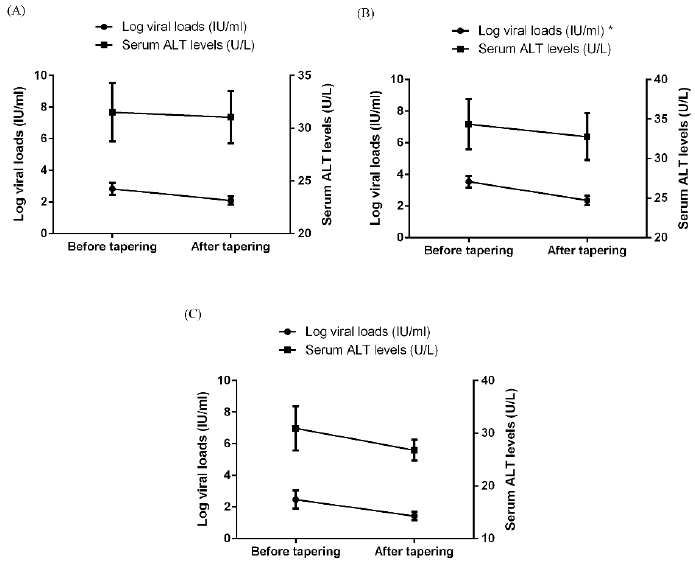
Figure 2. The change in serum levels of viral loads and ALT in RA patients with chronic hepatitis B before and after tapering of b/tsDMARDs, with respect to ( A ) all 40 patients, ( B ) 32 patients with detectable HBV DNA levels before tapering, and ( C ) 14 patients who used tocilizumab. Data are pre- sented as mean ± SEM. * p < 0.05. ALT, alanine aminotransferase; b/tsDMARDs, biological/targeted synthetic disease-modifying antirheumatic drugs; HBV, hepatitis B virus; RA, rheumatoid arthritis; SEM, standard error of